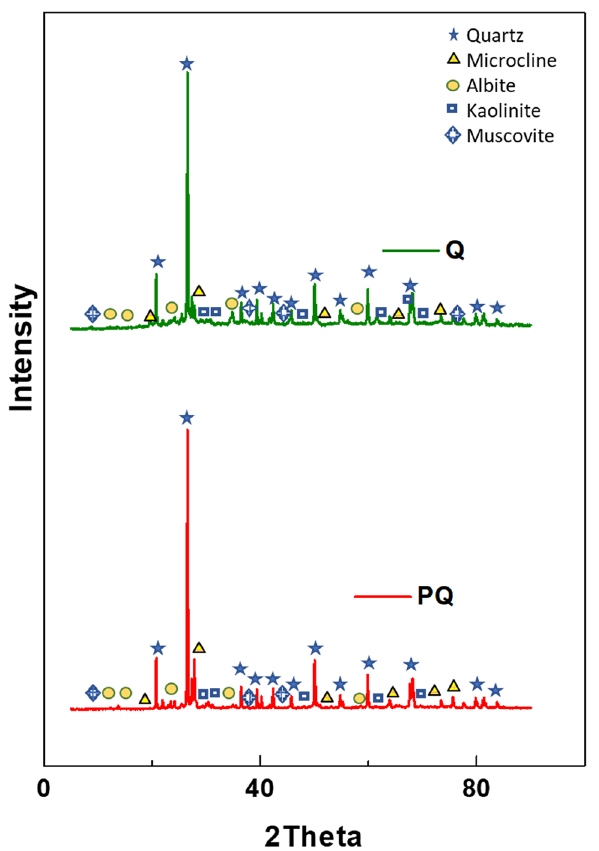
Figure 2. X-ray diffraction spectral for PQ and